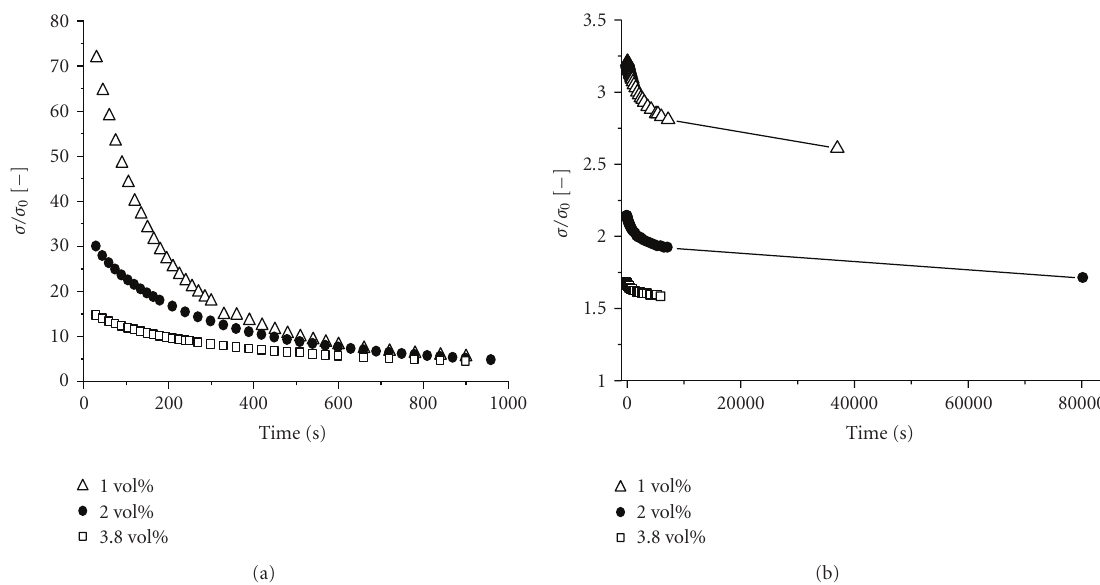
Figure 9: Photoconduction of cured MPS-Sb:SnO 2 /acrylate composites at di ff erent Sb:SnO2 concentrations (Sb = 13%; MPS / Sb : SnO 2 = 0 . 045 g/g). φ c = 0 . 3 vol. %. The lamp is switched o ff at time = 0s. For 1 vol.%: σ 0 = 1 . 3 × 10 − 6 S cm − 1 , 2 vol.%: σ 0 = 1 . 1 × 10 − 5 Scm − 1 , 3.8 vol.%: σ 0 = 6 . 7 × 10 − 5 S cm − 1 . (a) UV light. (b) Visible light.